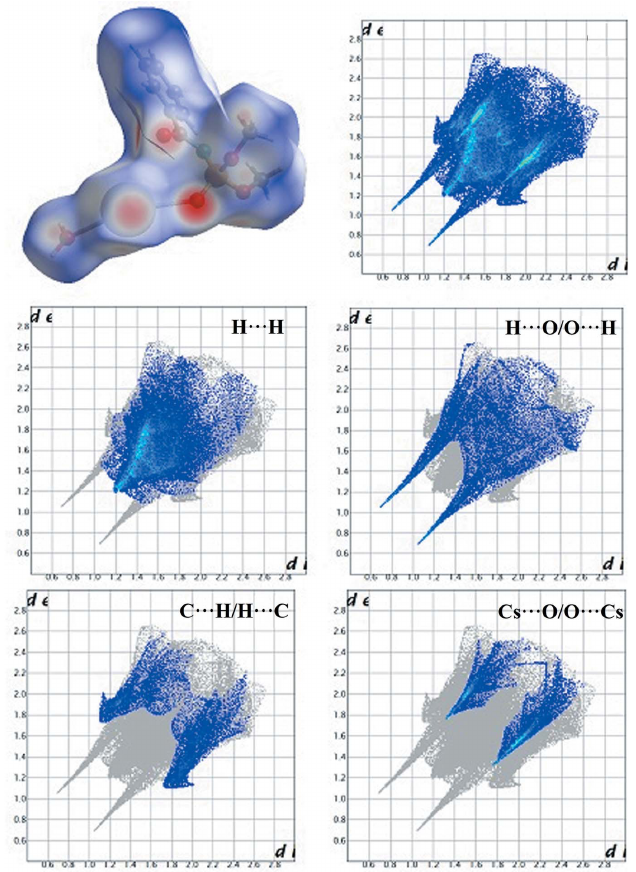
Figure 3 The Hirshfeld surface mapped over d norm and two-dimensional fingerprint plots for the H (cid:2)(cid:2)(cid:2) H (42.2%), H (cid:2)(cid:2)(cid:2) O/O (cid:2)(cid:2)(cid:2) H (19.3%), C (cid:2)(cid:2)(cid:2) H/ H (cid:2)(cid:2)(cid:2) C (14.3%) and Cs (cid:2)(cid:2)(cid:2) O/O (cid:2)(cid:2)(cid:2) Cs (12.9%) interactions for the asymmetric unit of the title compound